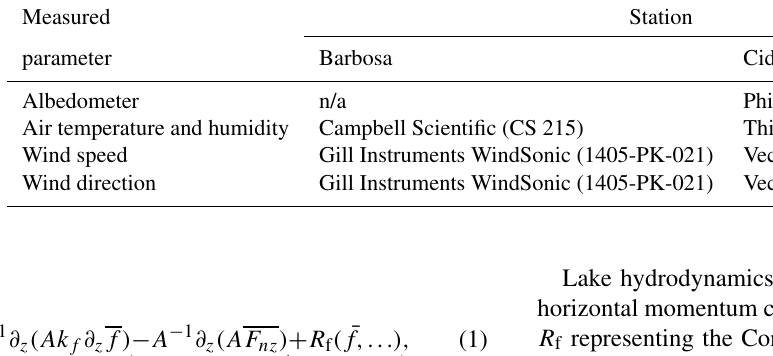
Table 1. Weather stations equipment. n/a – not applicable Measured Station parameter Barbosa Cid Almeida Albedometer n/a Philipp Schenk (8104) Air temperature and humidity Campbell Scientific (CS 215) Thies Clima (1.1005.51.512) Wind speed Gill Instruments WindSonic (1405-PK-021) Vector Instruments (A100R) Wind direction Gill Instruments WindSonic (1405-PK-021) Vector Instruments